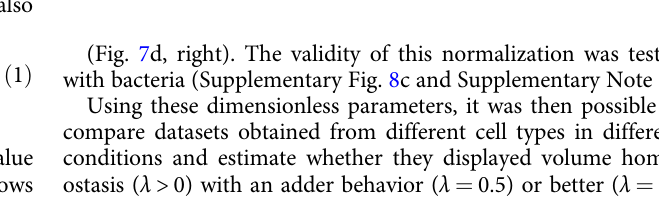
(Fig. 7d, right). The validity of this normalization was tested with bacteria (Supplementary Fig. 8c and Supplementary Note 1).